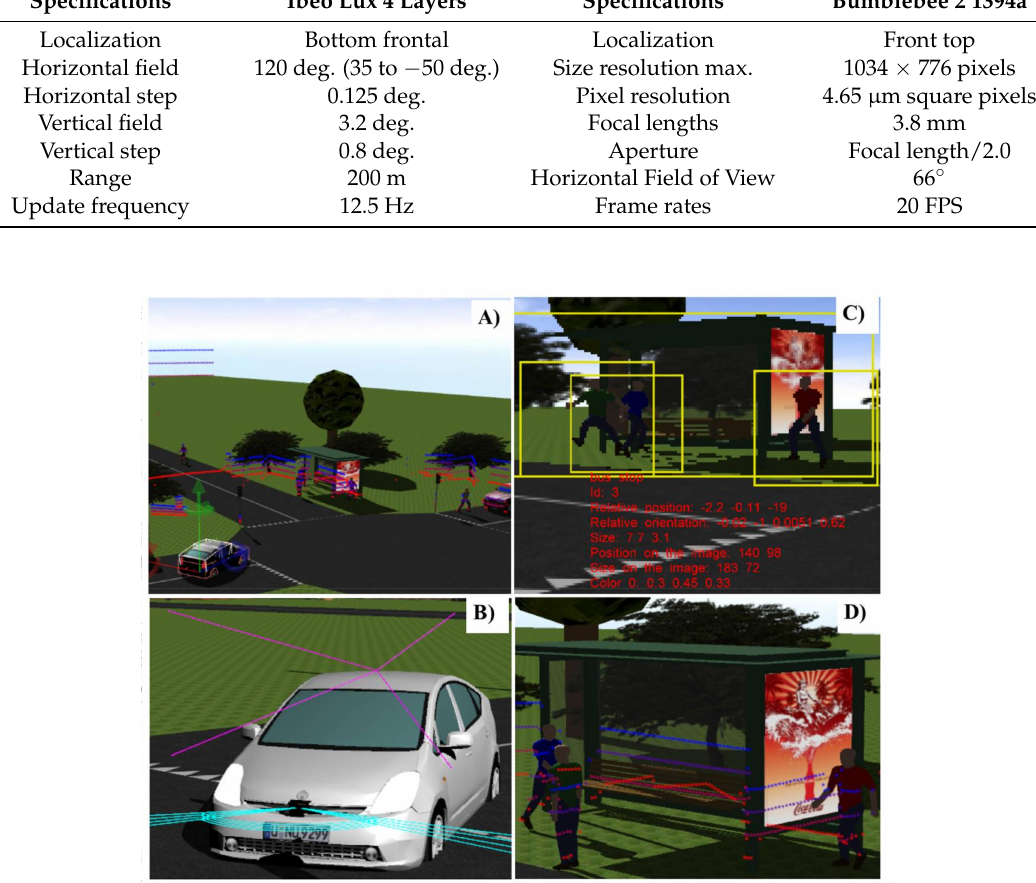
Figure 4. ( a ) Aerial view of simulated 3D scenario in Webots automobile; ( b ) Vehicle model with sensors incorporated; ( c ) Image captured by the camera and object detection procedure; ( d ) Point cloud projection from the LiDAR sensor over objects once